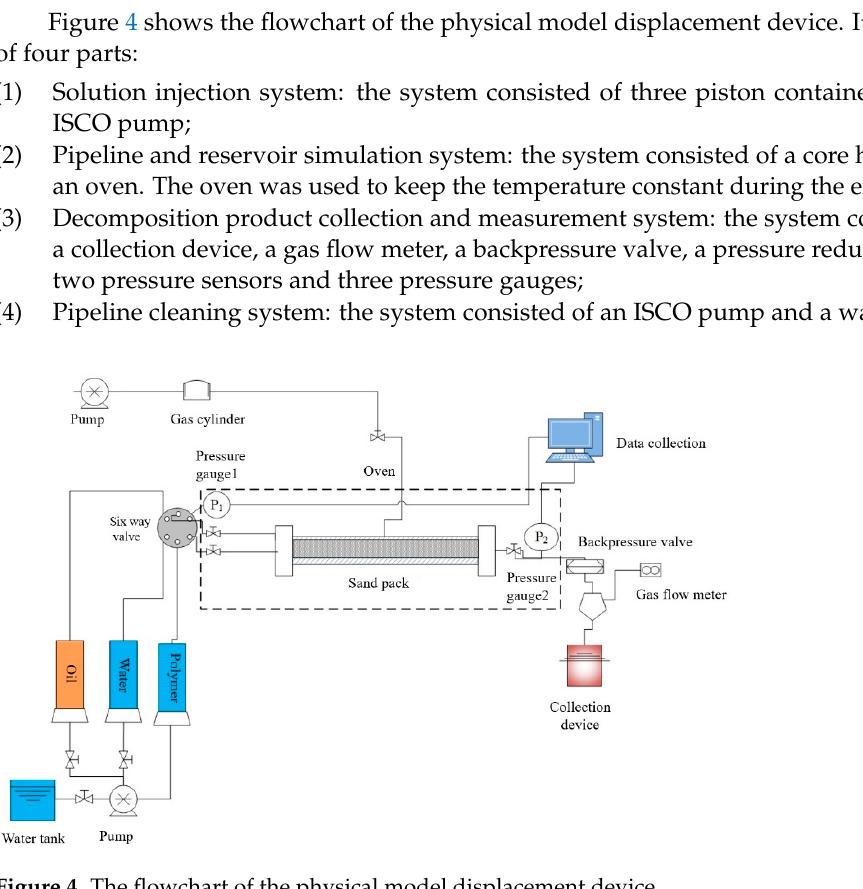
Figure 3. Physical picture of cores. Core A-300mD, Core B-600mD.